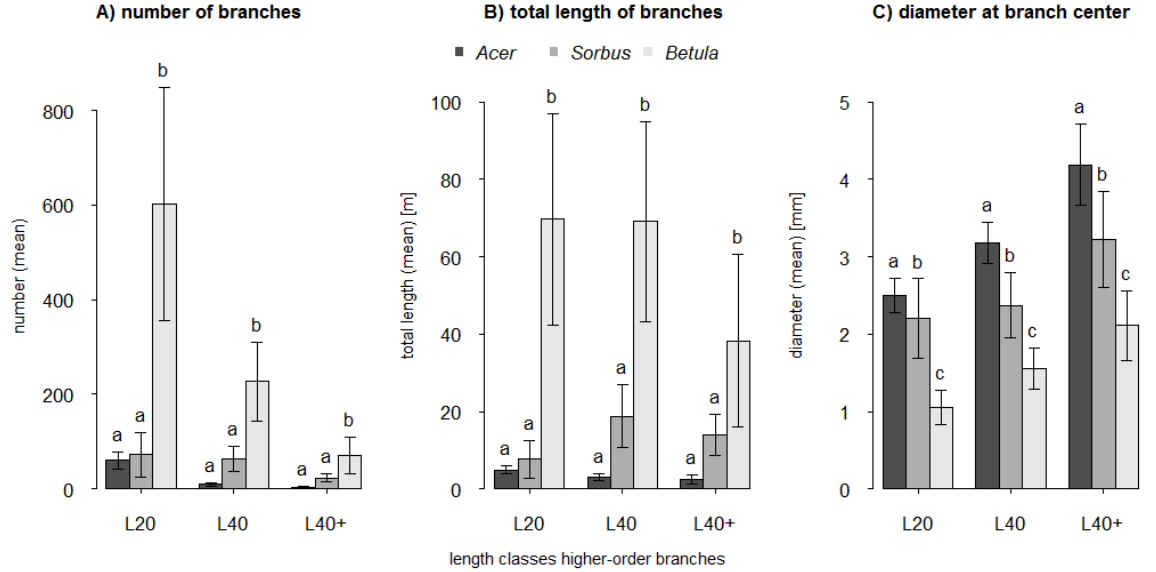
Figure 5. Barplots of mean values (and SD) of the structural complexity variables ( A ) branch number, ( B ) total length of branches and ( C ) diameter at branch center for higher-order branches and length classes: L20 ≤ 20 cm, 20 cm < L40 ≤ 40 cm, L40+ > 40 cm. Different lower case letters indicate significant differences between tree species in post hoc Tukey tests ( p <